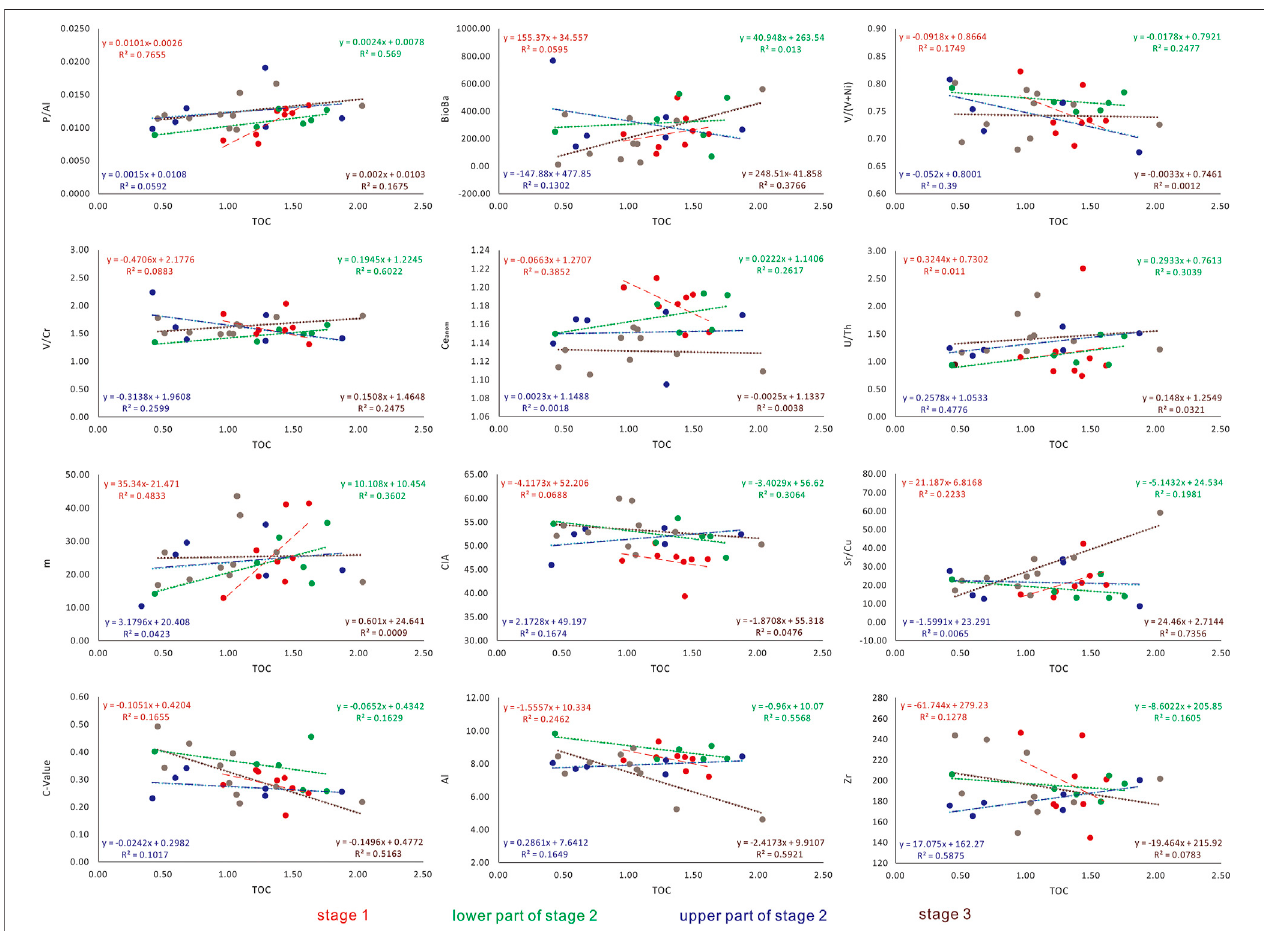
FIGURE 7 | The relationship between paleoproductivity proxies, redox proxies, paleosalinity proxies, paleoclimate proxies, terrigenous clastic proxies andTOC contents of three sedimentary stages of Laiyang group, in well LK-1.